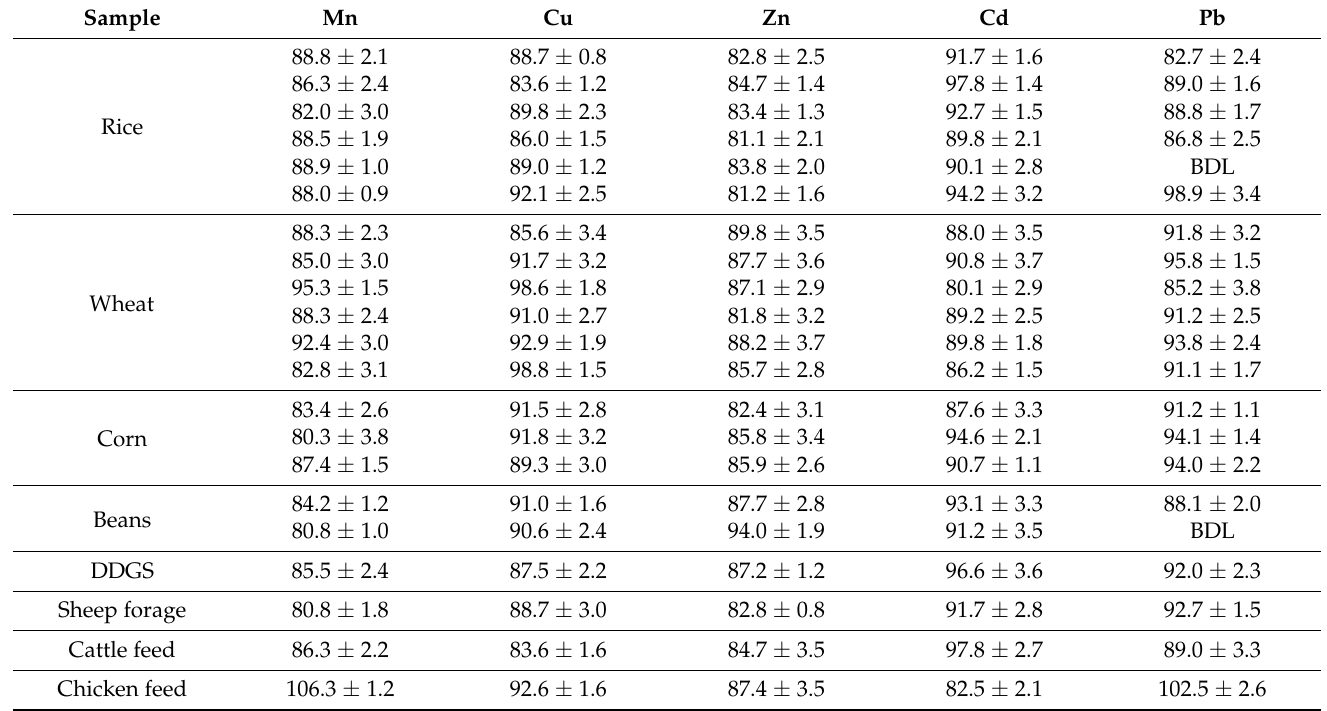
Table 2. The analyte recoveries in rice, wheat, corn, beans, feeds, and feeds’ raw materials ( n =